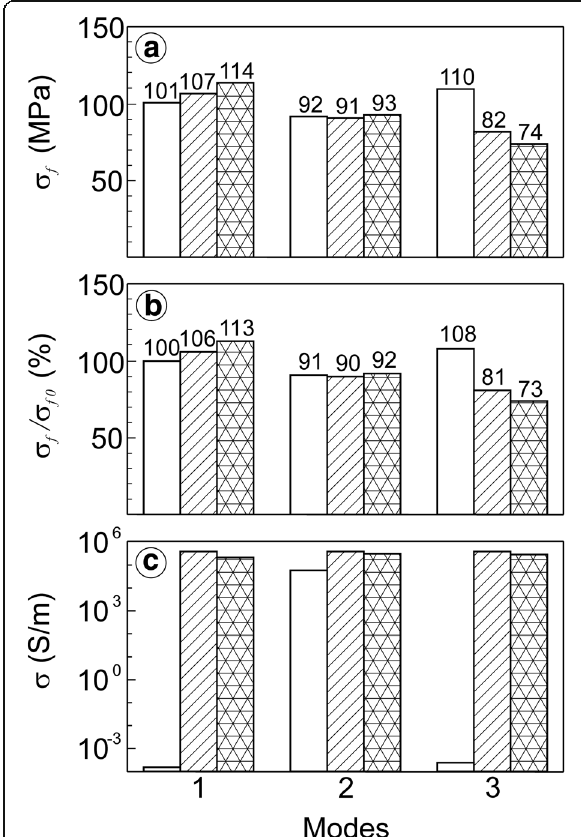
Fig. 2 Variation of a fracture stresses ( σ f ), b relative strength ( σ f / σ f0 ) and c specific electrical conductivity ( σ ) for materials test modes 1 – 3 (see Table 1). White bars — A series; hatched bars — R series; cross - hatched bars — RO series. Numbers above the bars indicate the values of corresponding parameters